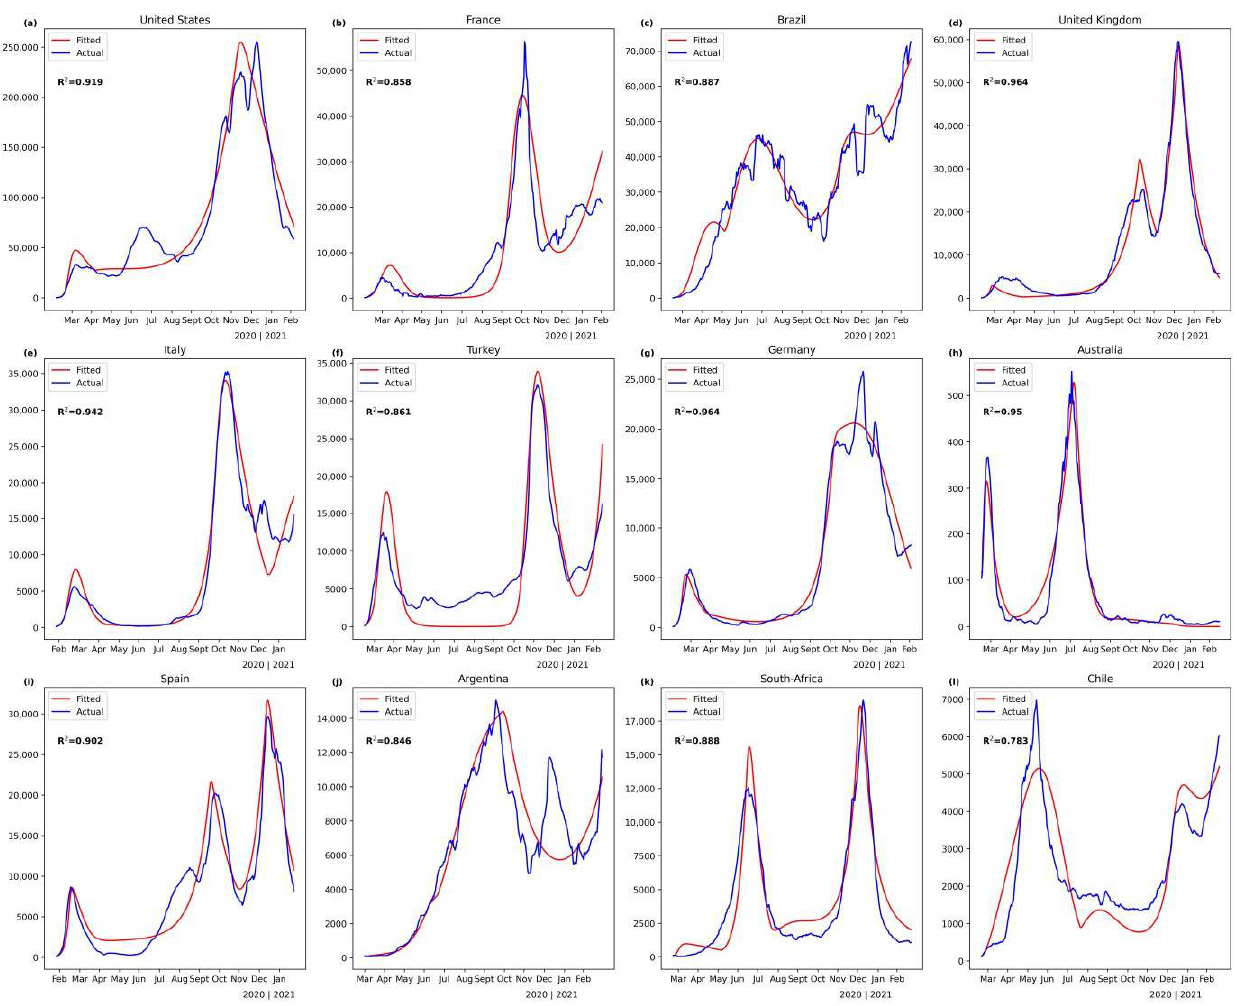
Figure 1. The curves of fitted and actual daily new confirmed cases for the selected countries. ( a ) United States; ( b ) France; ( c ) Brazil; ( d ) United Kingdom; ( e ) Italy; ( f ) Turkey; ( g ) Germany; ( h ) Australia; ( i ) Spain; ( j ) Argentina; ( k ) South-Africa; ( l ) Chile.